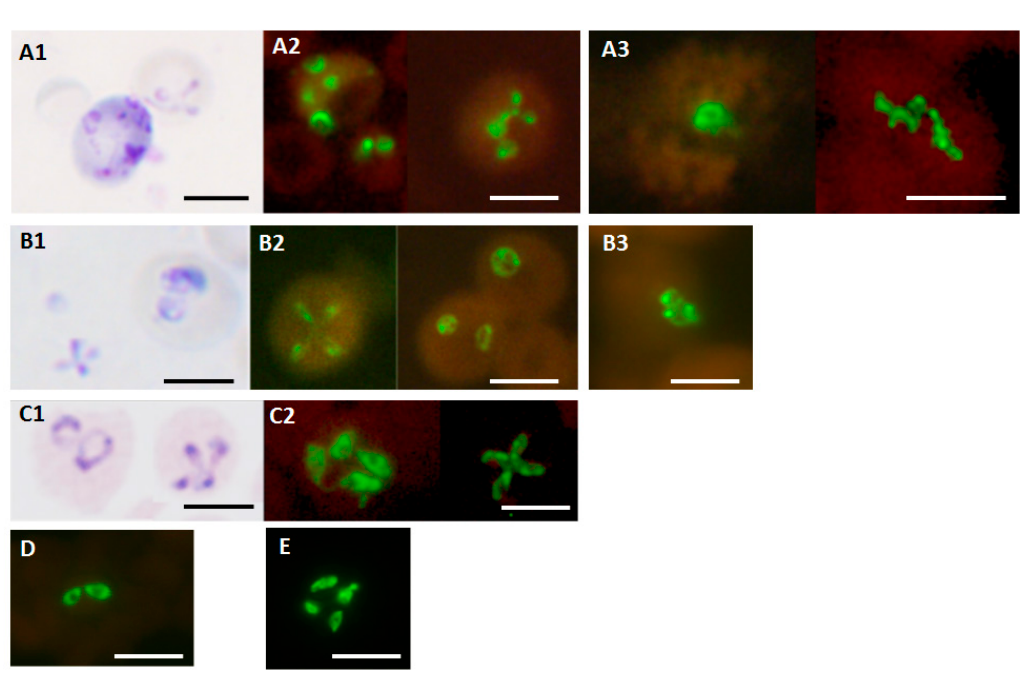
Table 2. Estimated clinical diagnostic parameters for the Babesia genus FISH test.